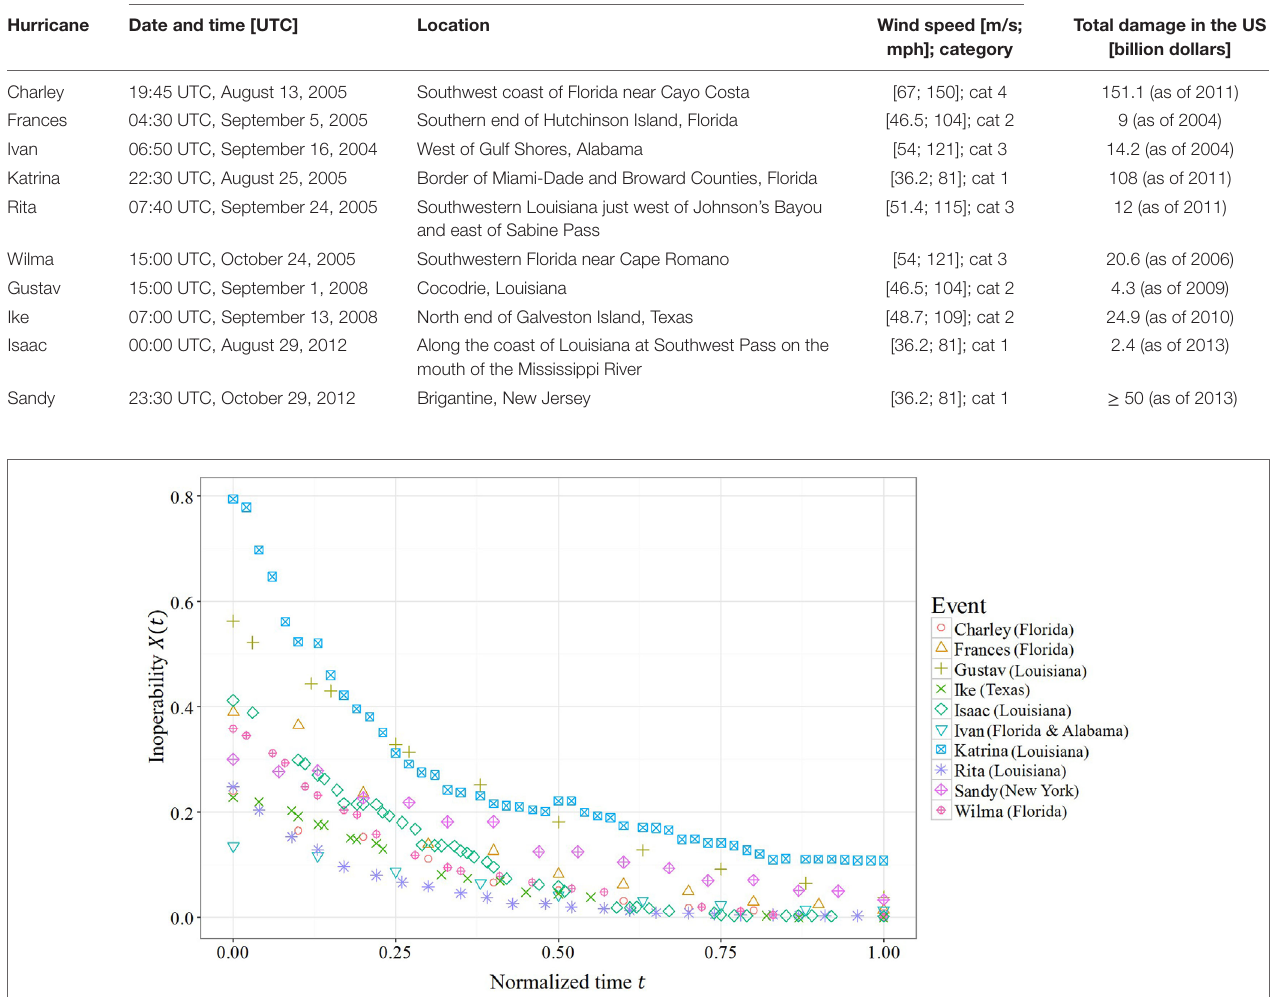
First landfall in the Us